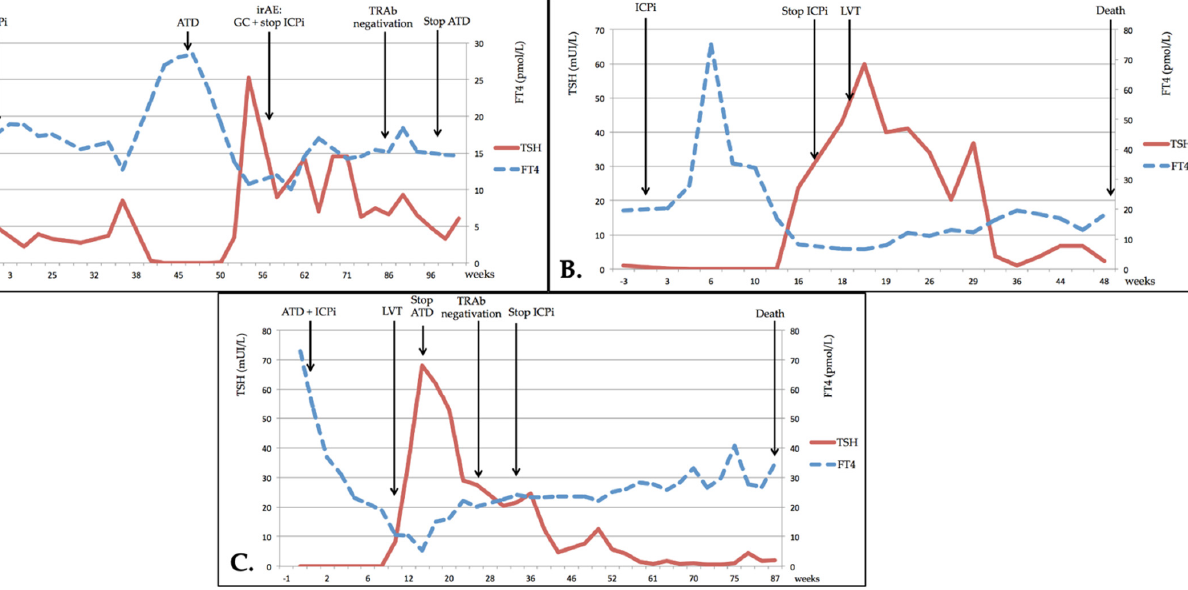
Table 1. ICPi-induced Graves’ disease.